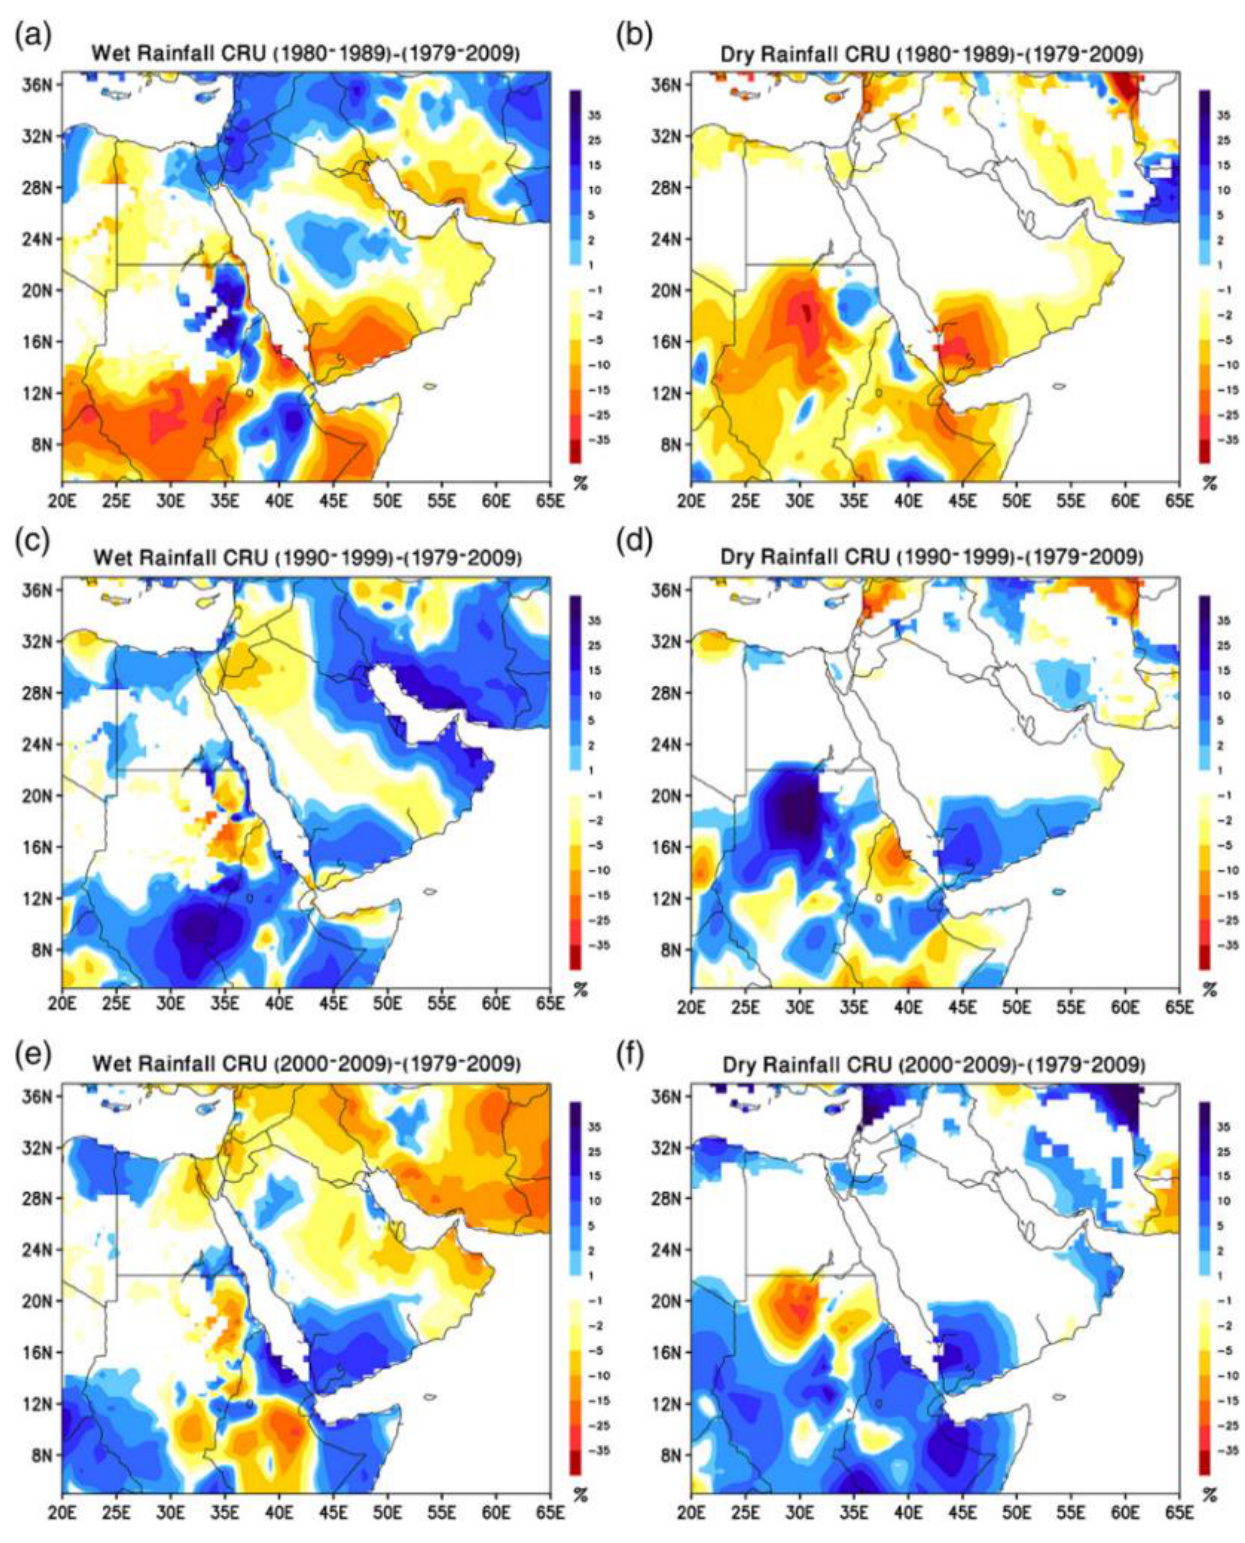
Figure 7. Spatial distribution of the wet rainfall change (%) for the decade ( a , b )1980–1989, ( c , d ) 1990–1999, and ( e , f )2000–2009 with respect to the base period (1979–2009) for the CRU dataset (left panels: (a,c,e)) and the dry season (right panels: (b,d,f)) [19]. On the contrary, the wet season precipitation through the dry season over SA is low and mostly restricted to the southwest region, as described earlier. Through the dry season, the precipitation